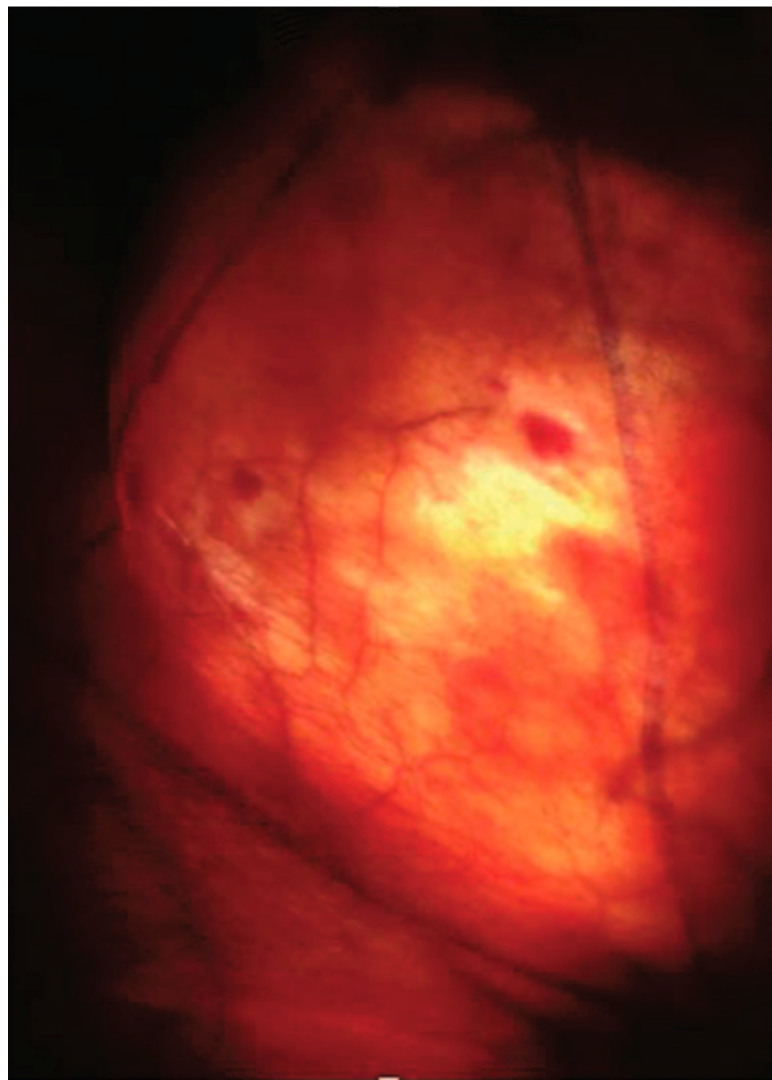
Figure 4. Transillumination of skin flap delineates arterial supply. Copyright owned by Master et al.